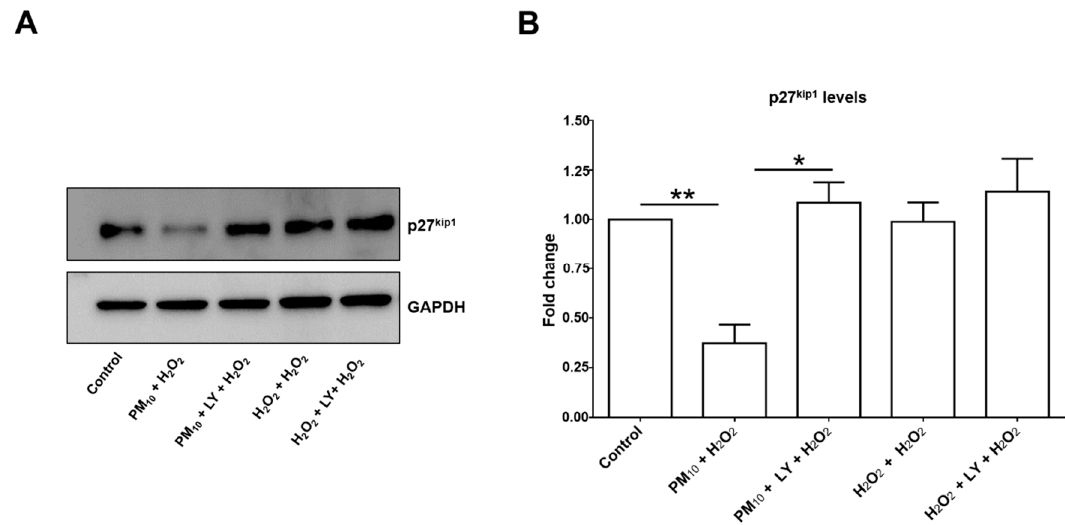
Figure 6. Representative blot of ( A ) assessed p27 kip1 levels and ( B ) densitometry using ImageJ software. Lung epithelial cells were pre-exposed to PM 10 (10 µ g / cm 2 ) for 24 h, and then cells were treated with H 2 O 2 (500 µ M) for 24 h. In lane 3 and 6 of the blot (panel A ) are cells treated with LY294002 inhibitor (50 µ M) for 1 h before the H 2 O 2 (500 µ M) treatment. Glyceraldehyde 3-phosphate dehydrogenase (GAPDH) protein was used as loading control for western blot. ** p < 0.001 versus control; * p < 0.001 versus PM 10 + H 2 O 2 . The image is representative of three independent experiments, and values are the mean ± SD of three independent experiments.